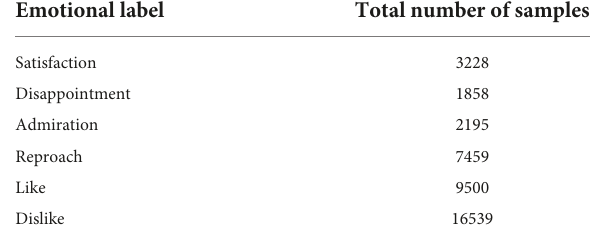
TABLE 1 Distribution of semantic emotional labels.